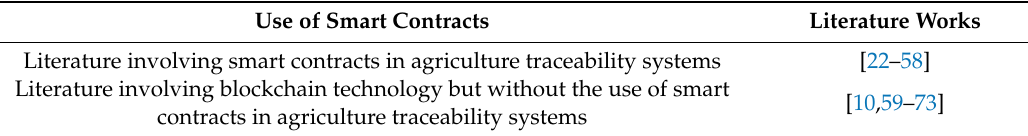
Table 1. Survey or research works in the agriculture traceability systems—classification depending on the usage (or not) of smart